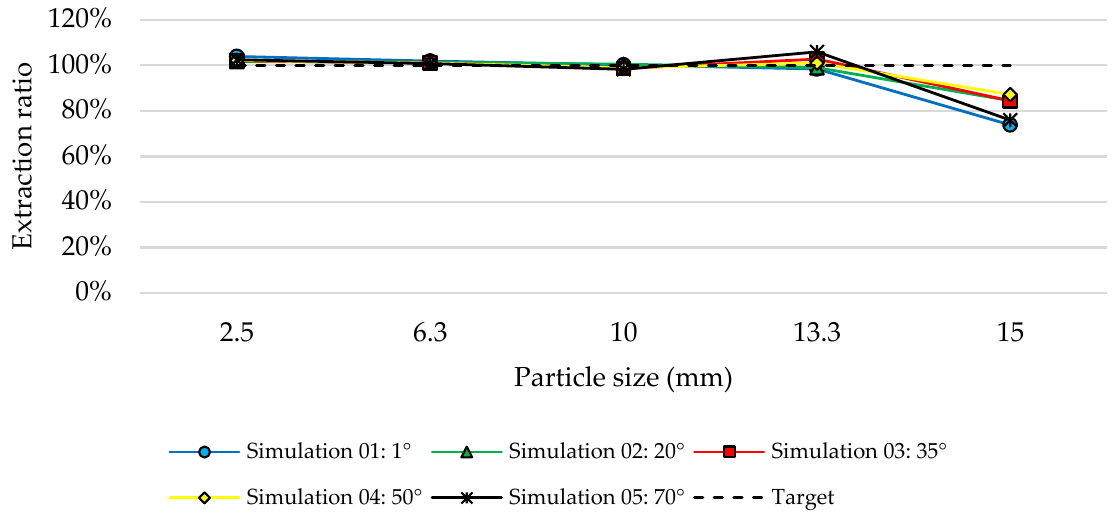
Figure 10. Extraction in cross-stream cutter as function of the cutter edge angle.